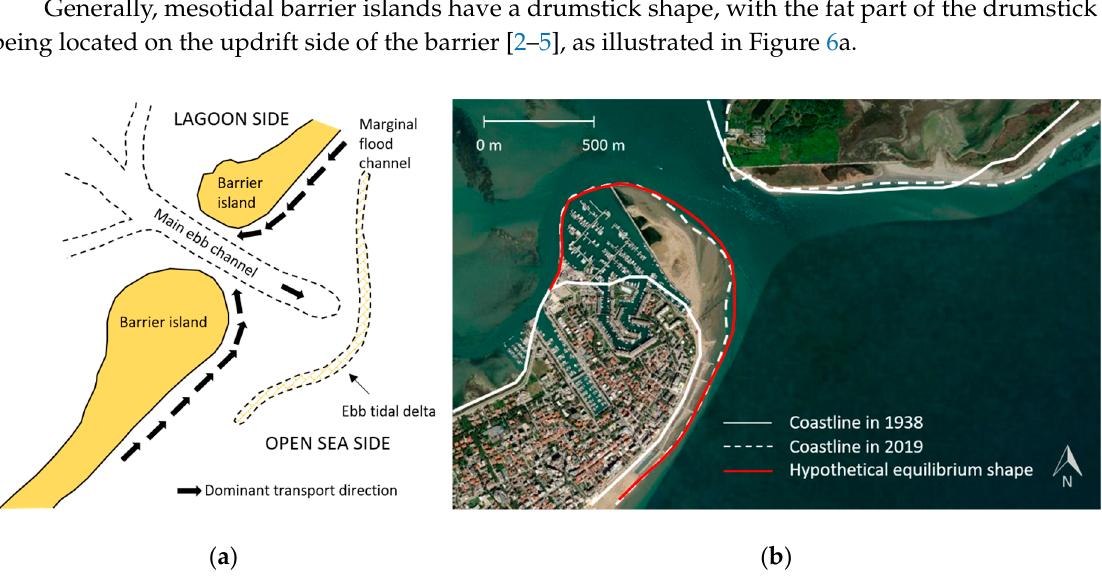
Figure 5. Historical reconstruction of the sand deposit from 1988 to 2019: computed area of horizontal surfaces enclosed by the lines for each year.